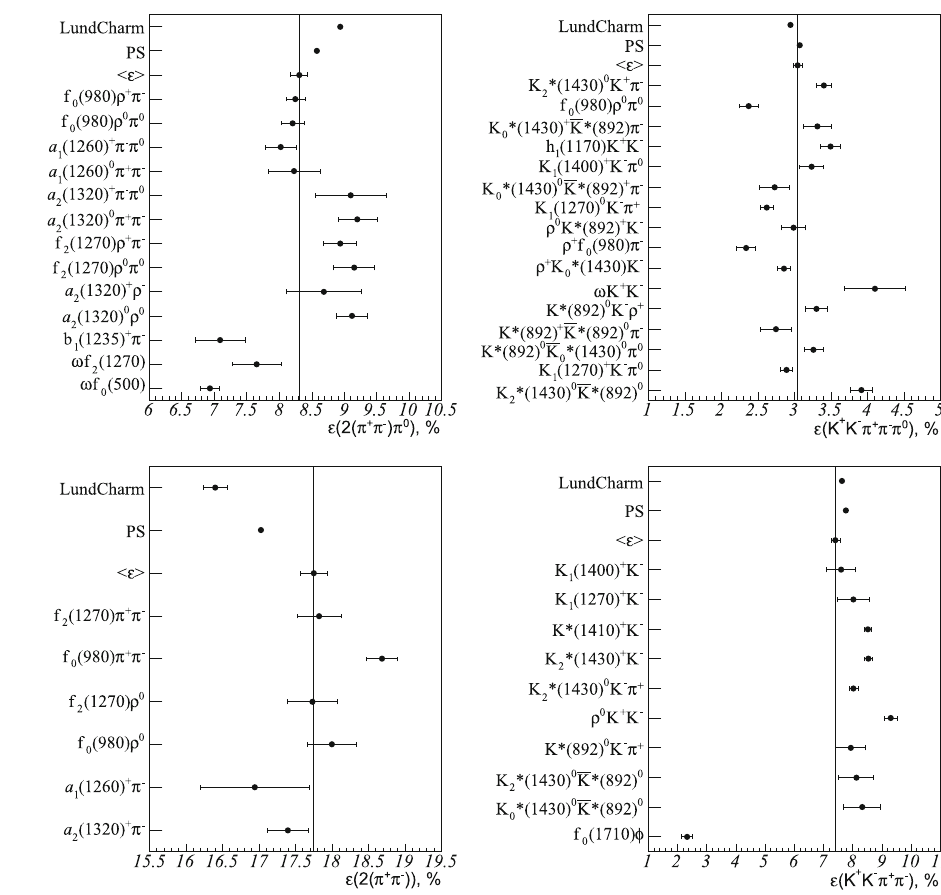
Fig. 2 Detection efficiencies for different modes of J /ψ decays into the final states 2( π + π − )π 0 , K + K − π + π − π 0 , 2( π + π − ) and K + K − π + π − π 0 . Error bars show the systematic uncertainties associated with the uncertainties in the helicity amplitudes. < ε > denotes the mode-averaged detection efficiency for a given final state. Also shown are the detection efficiencies determined from simulations using the uniform phase space distributions for final particles (denoted as PS) and from simulations using the LundCharm